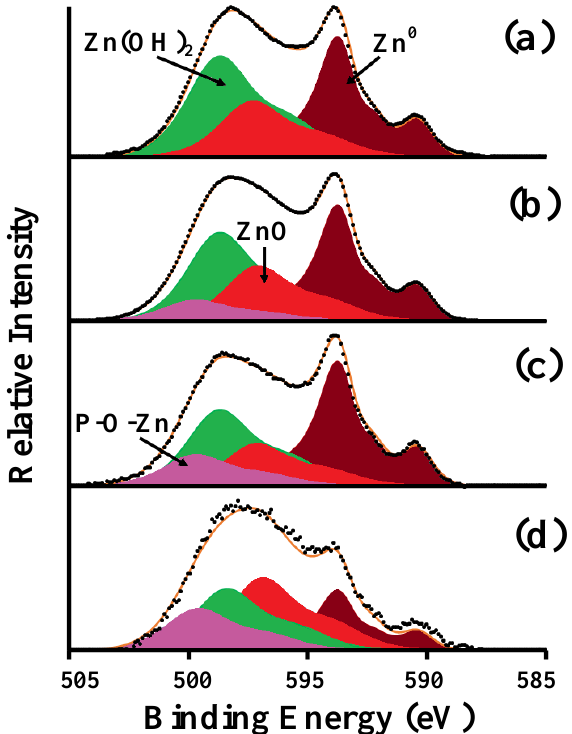
Figure 6. Auger ZnL 3 M 45 M 45 spectra of zinc samples with “smooth” surface (Type 1) ( a ) before and ( b – d ) after treatment in solution of 2.5 mM SDDP. The electron emission angle relative to the sample surface: ( a , b ) 90, ( c ) 50, and ( d ) 15°.